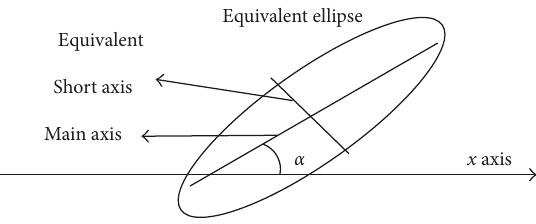
Figure 12: Particles’ orientation of main axis.